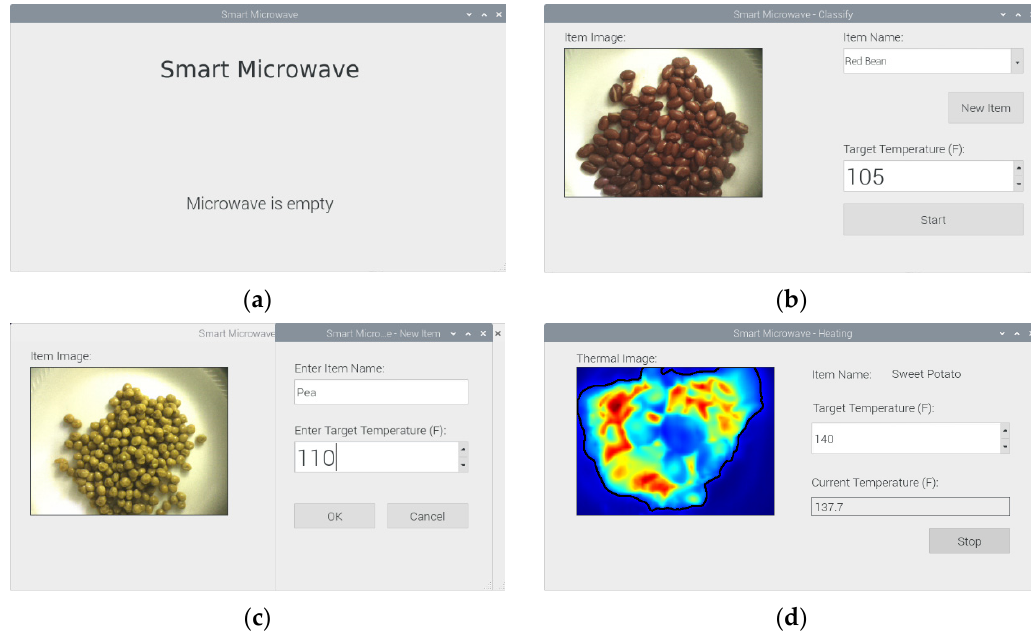
Figure 8. Photograph of the prototype hardware: ( a ) embedded system interfaced with a commercial microwave oven. The Raspberry Pi microcontroller is attached at the backside of the display unit; ( b ) top view of the oven showing the hardware components: (1) RPi HD camera; (2) FLIR thermal camera; (3) Relay (4) SSR; (5) Speaker;.